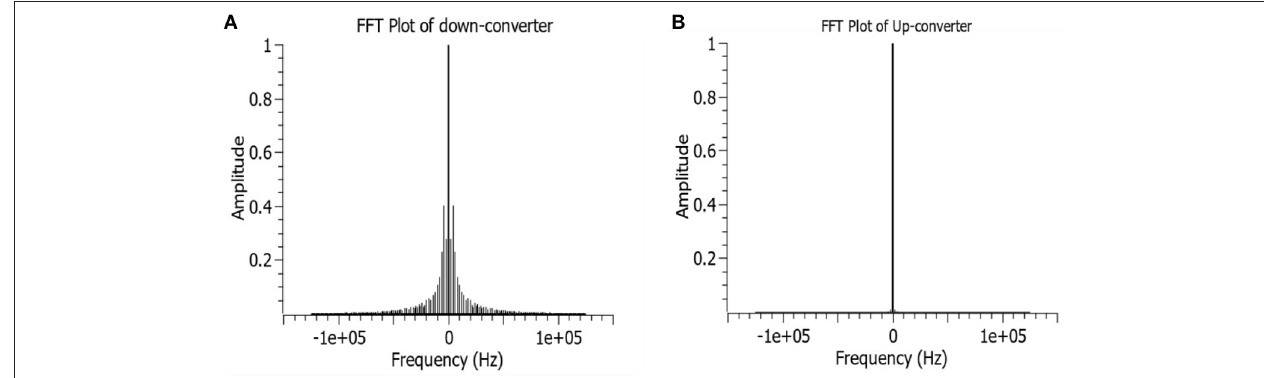
Frontiers in Energy Research |